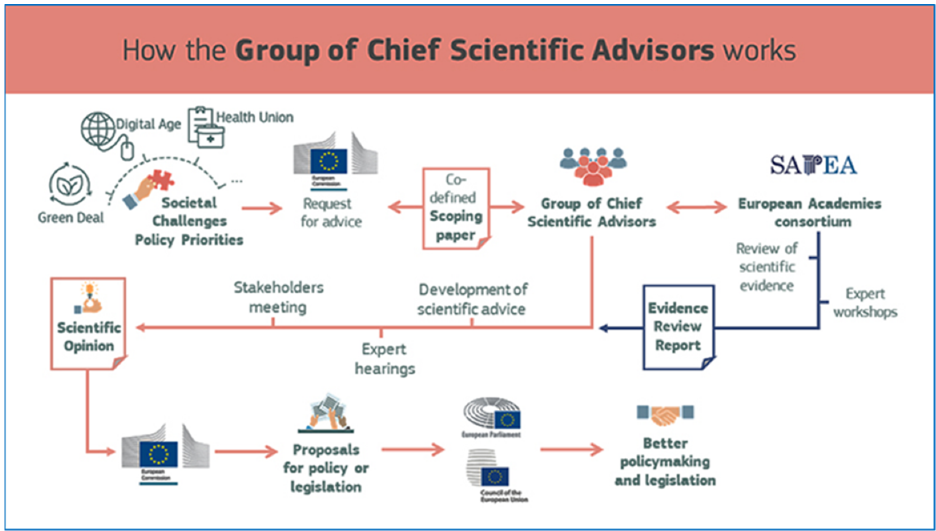
Figure 3. The Federation of European Academies of Medicine (FEAM) collects, presents and reviews the evidence for the Commission’s Group of Chief Advisors (SAPEA). SAPEA will then draft a proposal of recommendations to the European Commission.